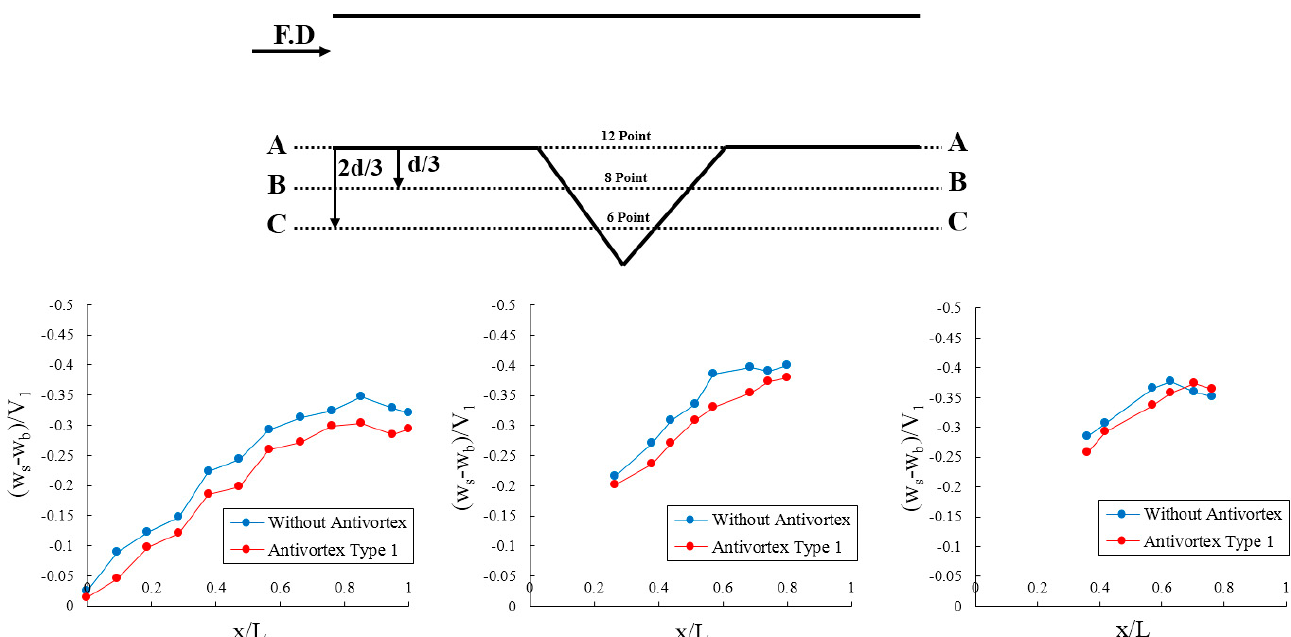
Figure 11. The secondary flow intensity along of the triangular labyrinth side weir with and without antivortexes.